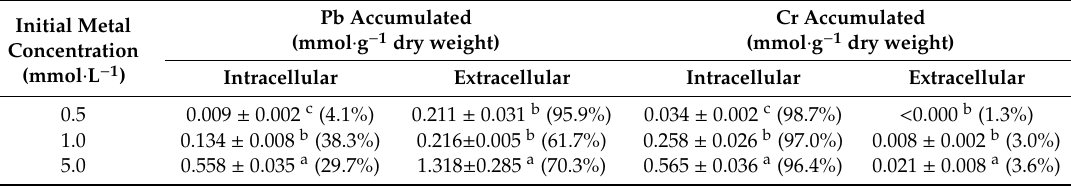
Table 1. Heavy metal intracellular and extracellular bioaccumulation (mmol · g − 1 dry weight) of Bacillus sp. MRP-3 under di ff erent Pb and Cr stress. Values in the same column with di ff erent letters (a–c) are significantly di ff erent at p <